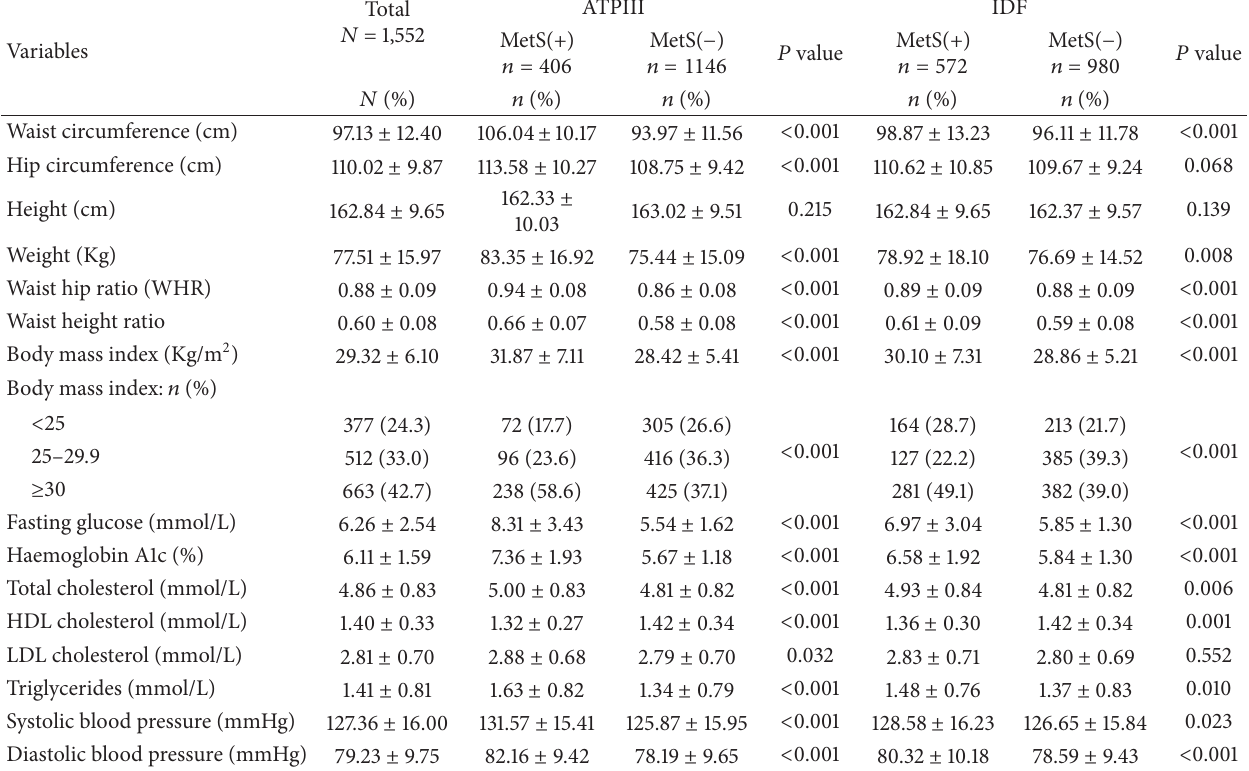
Table 2: Anthropometric measurements and clinical parameters of the study sample in Qatar ( 𝑁 = 1 , 552 ).